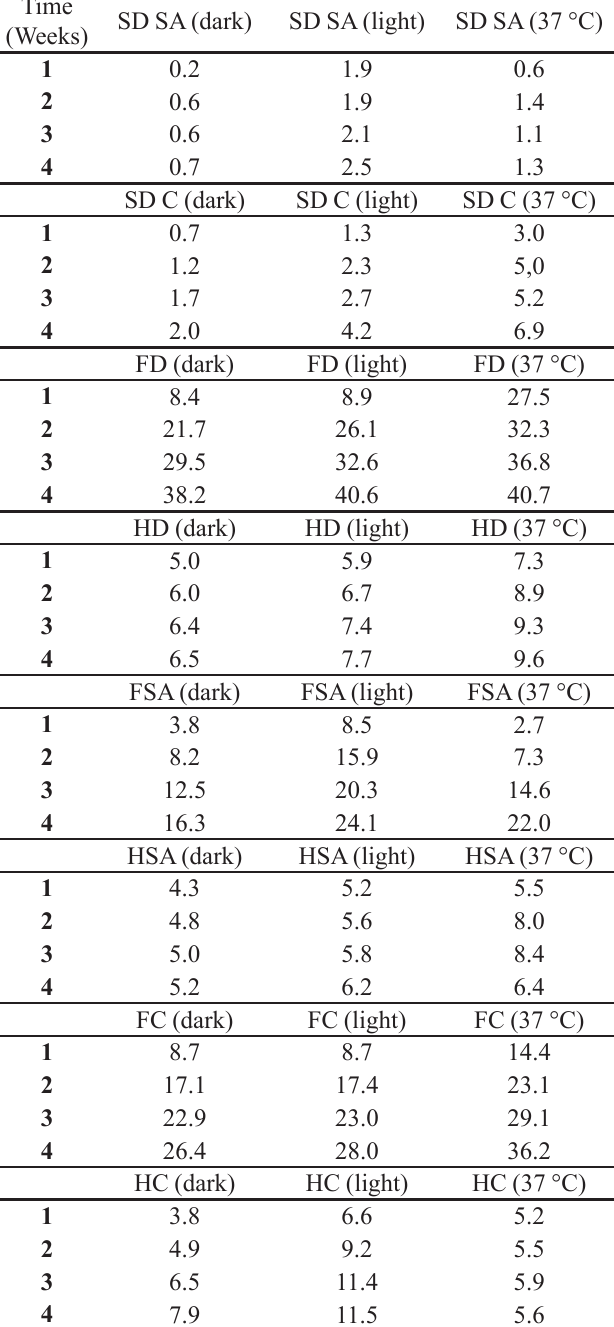
TABLE II – Color testing results (ΔE values) of samples at different times stored under different conditions,